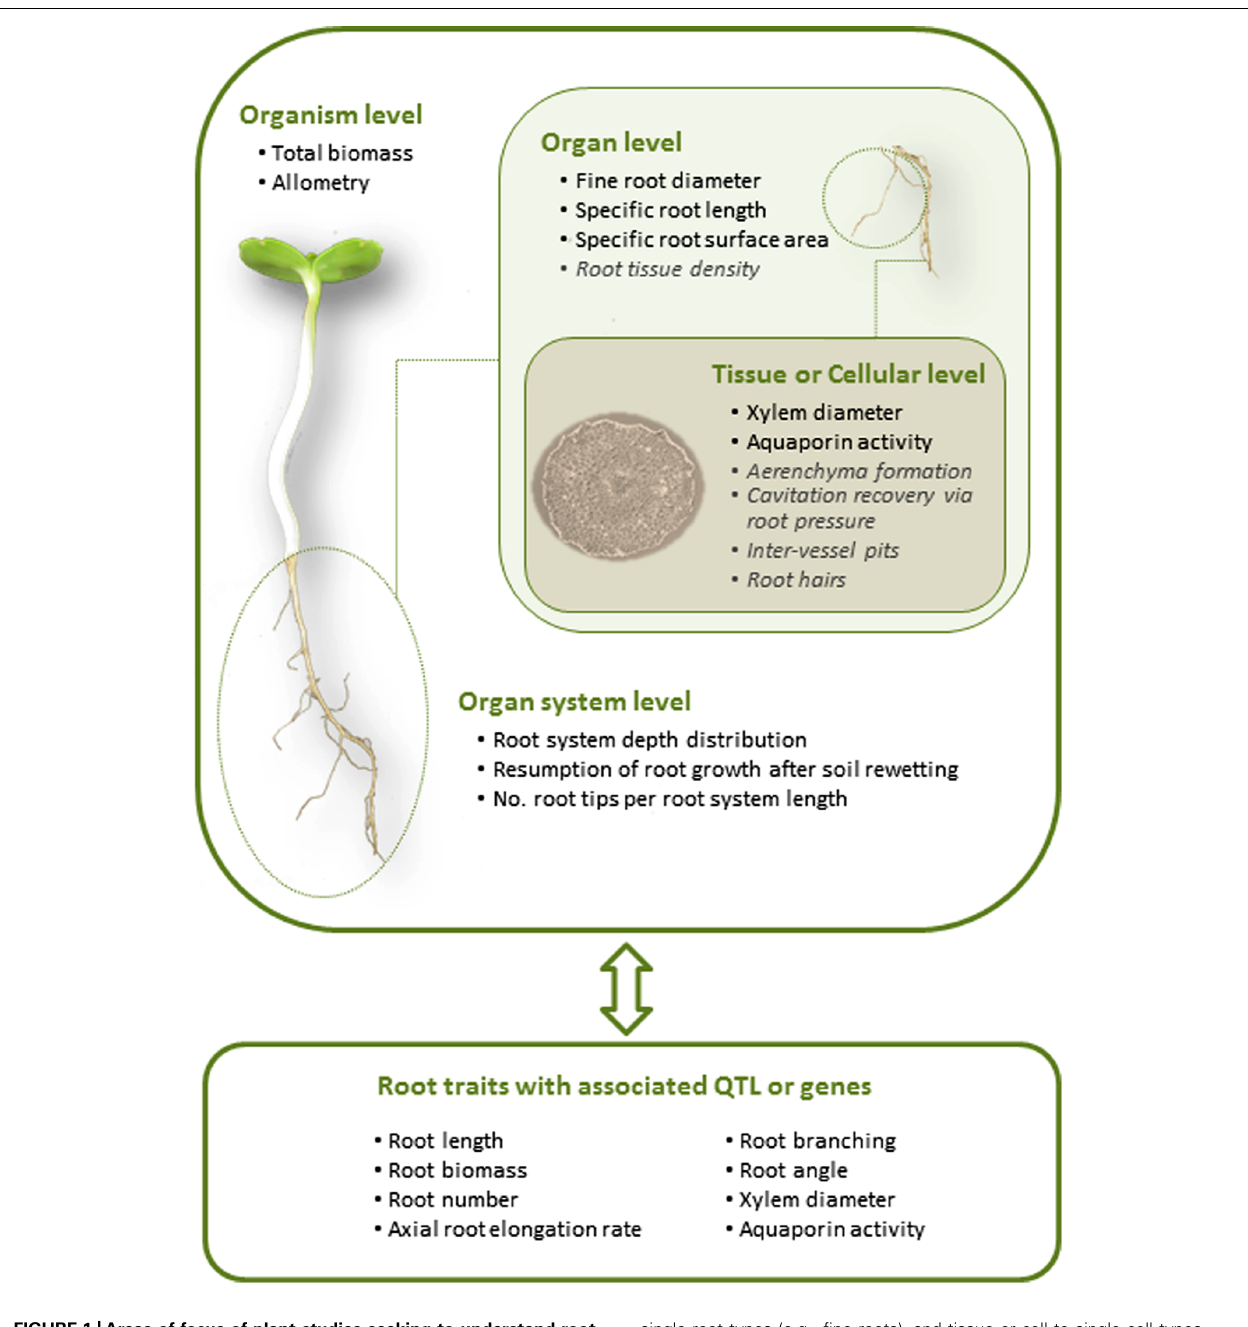
FIGURE 1 |Areas of focus of plant studies seeking to understand root traits related to plant productivity under water shortages and genetic screening of traits to identify their coding. Organism level refers to whole plant traits, organ system to the entire root system (fine and coarse roots, as the shoot system would refer to leaves and stems), organ to